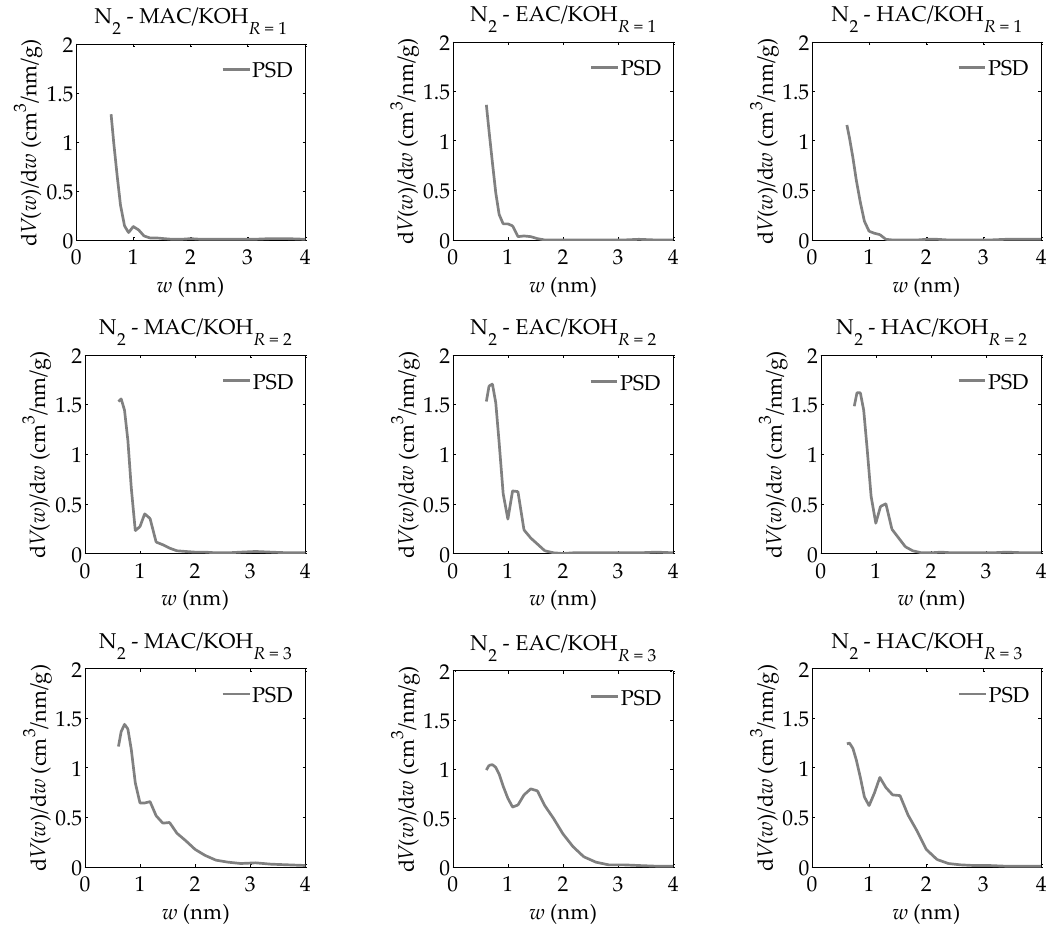
Figure 4. The pore size distributions obtained for all analyzed samples of activated carbons on the basis of nitrogen adsorption isotherms using the QSDFT method.